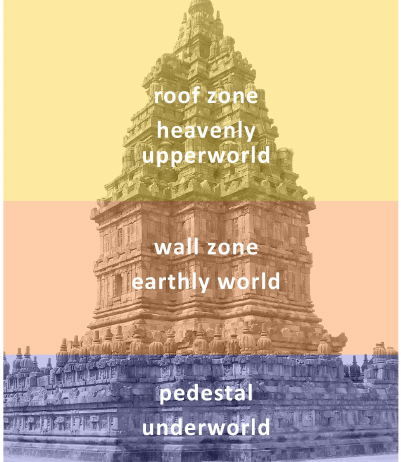
Figure 1. The tripartite symbolic concept: Prambanan , Candi Ś iva Loro Jonggrang , elevation with overlaid spheres (Lehner, 2013)